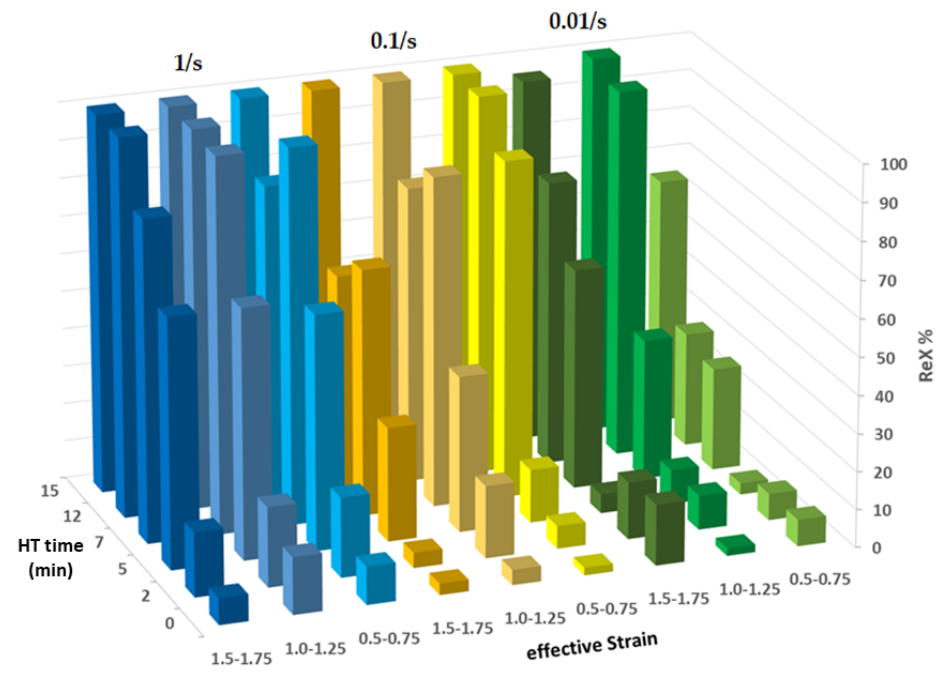
Figure 5. Chart showing amount of recrystallization evolution with respect to strain region, deformation strain rates, and annealing time at annealing temperature of 950 °C.